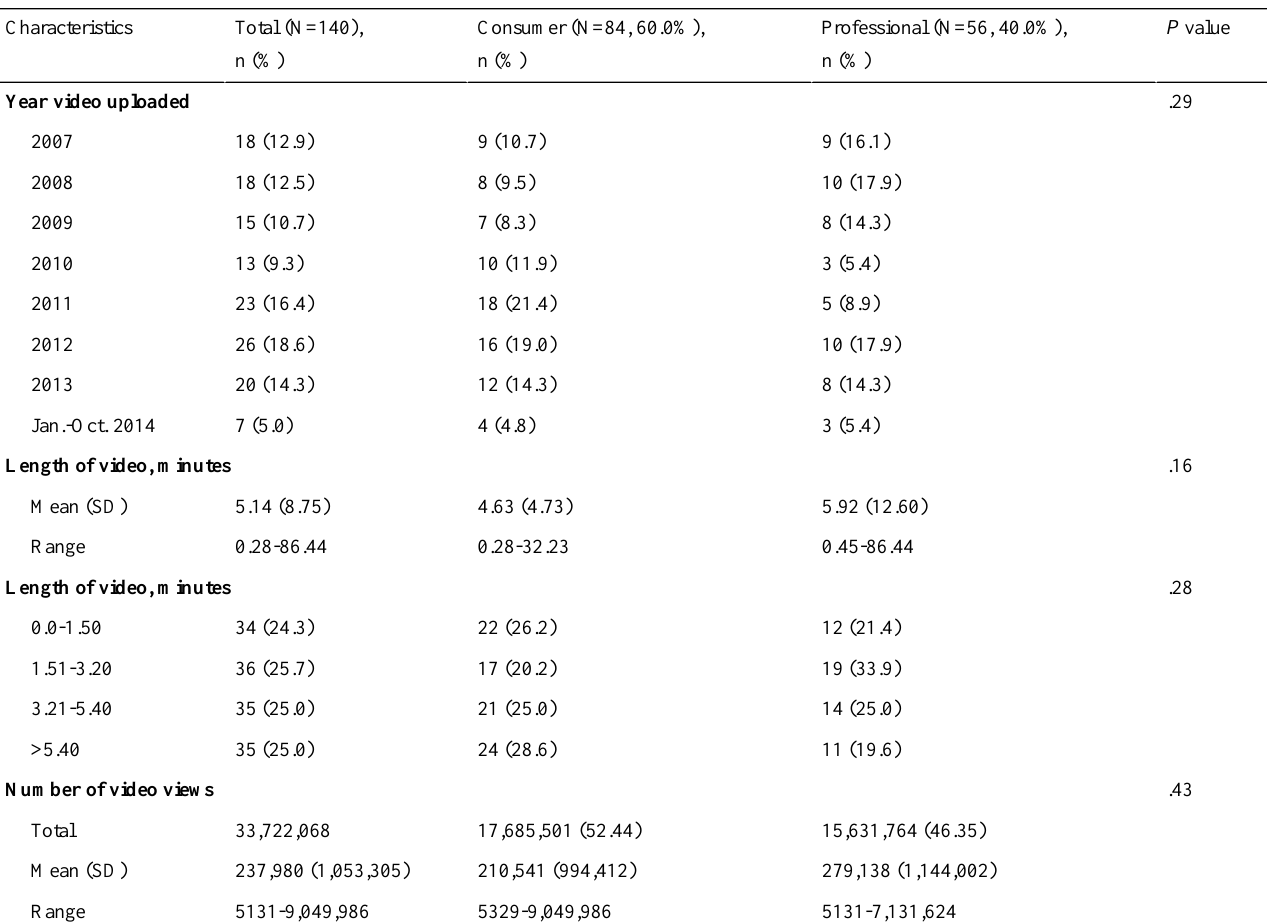
Table 1. Characteristics of 140 popular skin cancer screening videos posted on YouTube.